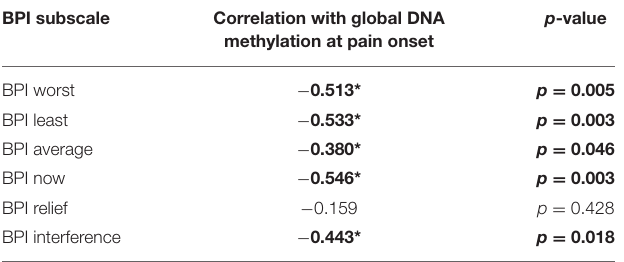
TABLE 8 | Brief pain inventory (BPI) subscales correlation with DNA methylation. BPI subscale Correlation with global DNA methylation at pain onset